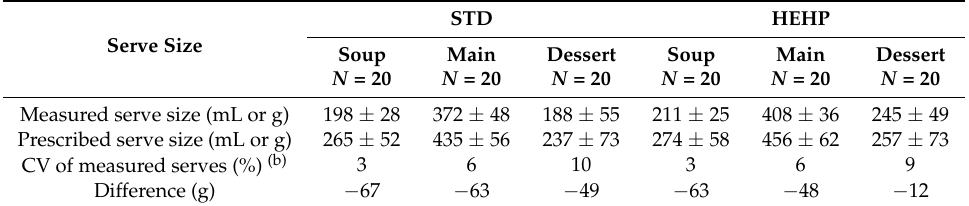
Table 2. Prescribed and measured serve sizes and mean coefficient of variation of each menu item within the ‘Standard’ and ‘High Energy and Protein’ meals